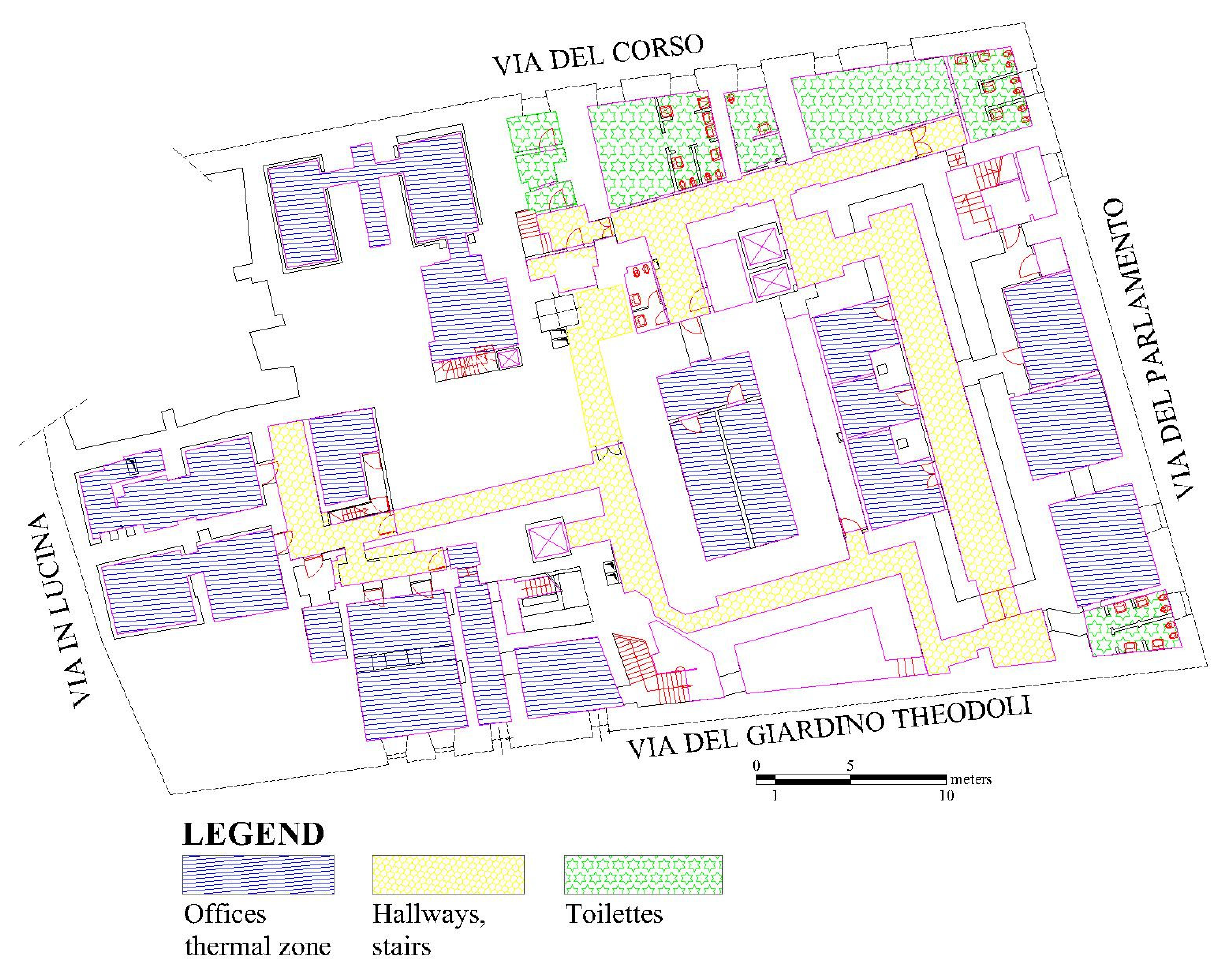
Figure 3. Designated uses on the Int/basement floor.